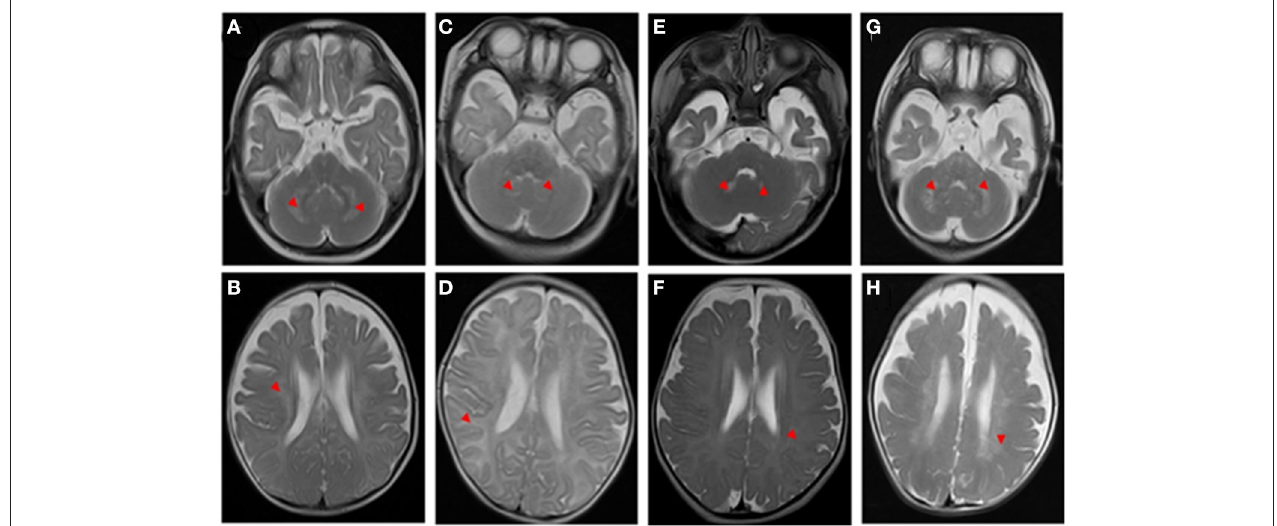
FIGURE 1 | T2-weighted brain magnetic resonance imaging (MRI) of the patients. The red arrowheads show the lesions. Neuroimaging findings ( A,B , case 1)at the 5-month-old show a cerebellar dentate nucleus and white matter were damaged, and the subcortical U-shaped fibers were significantly involved; ( C,D , case 2) at a 3-month-old show diffuse lesions in white matter, obvious subcortical involvement of U-shaped fibers, and suspicious lesions in cerebellar dentate nuclei; ( E, F , case 3) at a 3-month-old show suspicious lesions in the cerebellar dentate nucleus and the change of cerebral white matter is not prominent; (G,H) at the 6-month-old evident lesions in the cerebellar dentate nucleus.